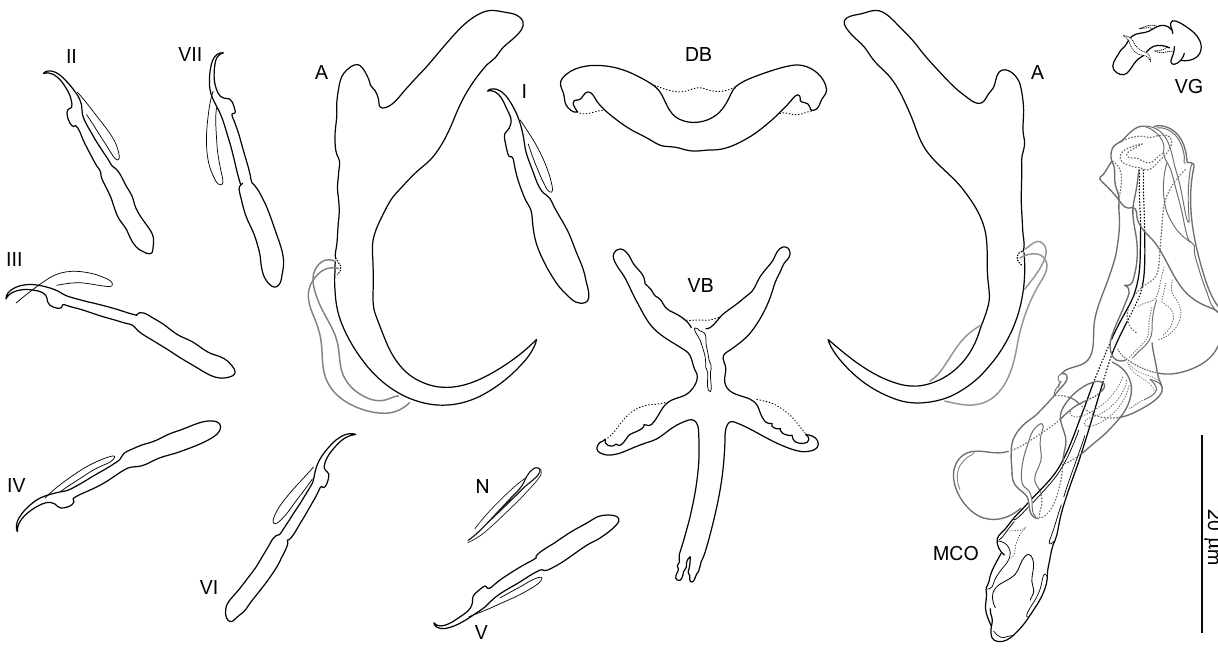
Figure 7. Sclerotized structures of Dactylogyrus remi n. sp. ex Luciobarbus graecus . A, anchor; DB, dorsal bar; VB, ventral bar; N,